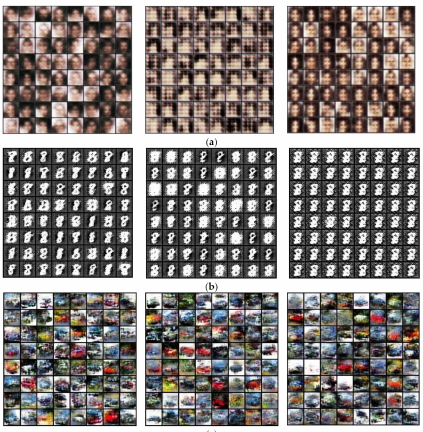
Figure 7. The samples generated by different models. ( a ) WGAN-GP, ( b ) SAGAN, ( c )